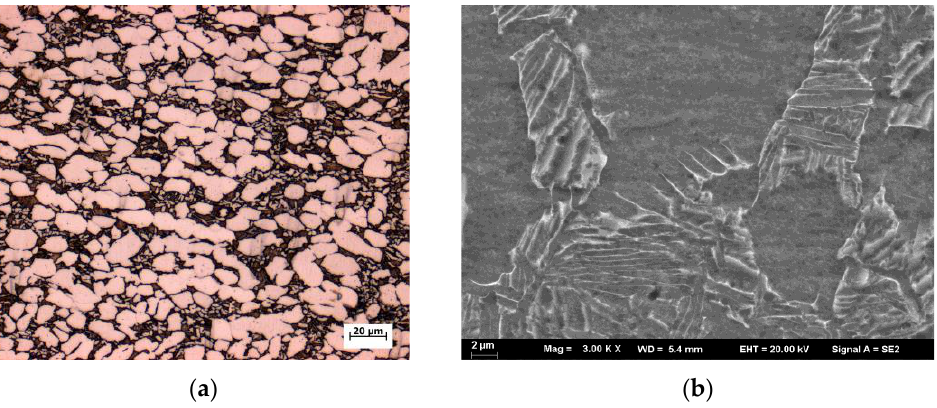
Figure 3. ( a ) Optical microscopic and ( b ) SEM microstructure of forged Ti-6Al-4V alloy. Figure 4 presents the microstructure of the SLMed Ti-6Al-4V alloy, showing different microstructural features from the commercially forged one. A large amount of acicular α (cid:48) martensite as well as the presence of defects are evident in Figure 4a, and the formation of the α ’ martensite was related to the rapid cooling rate. Figure 4b is the TEM microstructure of the SLMed Ti-6Al-4V alloy. It can be seen that a large amount of α p , α s and β